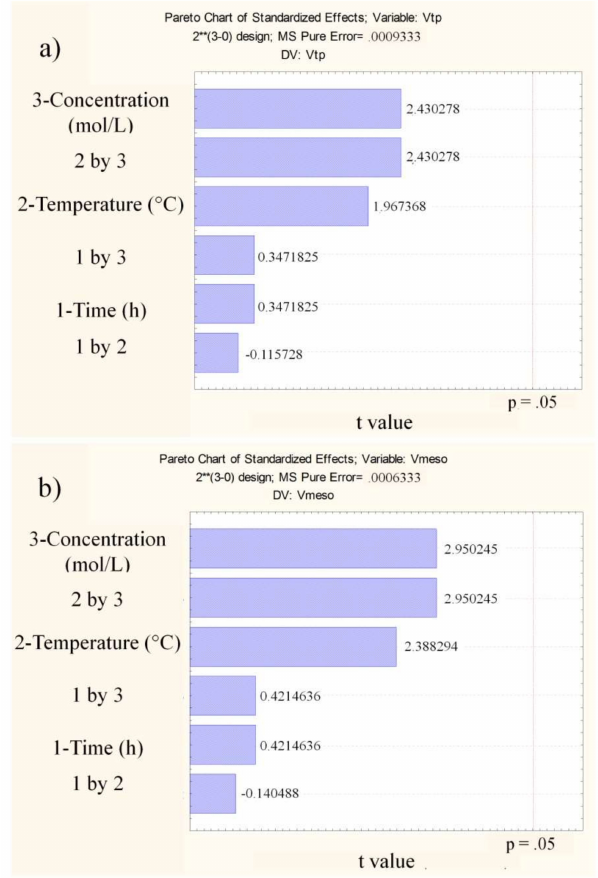
Figure 7. Pareto graphs of ( a ) the total pore volume and ( b ) the mesopore volume.